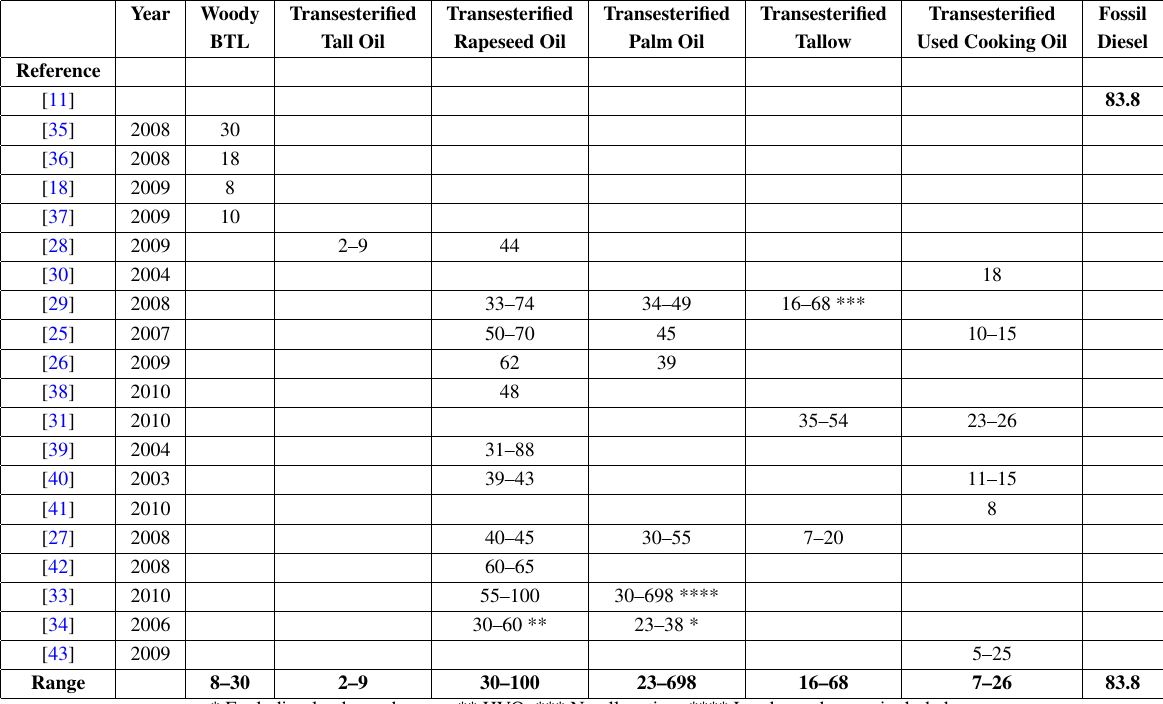
Table 3. Comparison of GHG emissions ( CO transesterified lipid and BTL from different feedstock